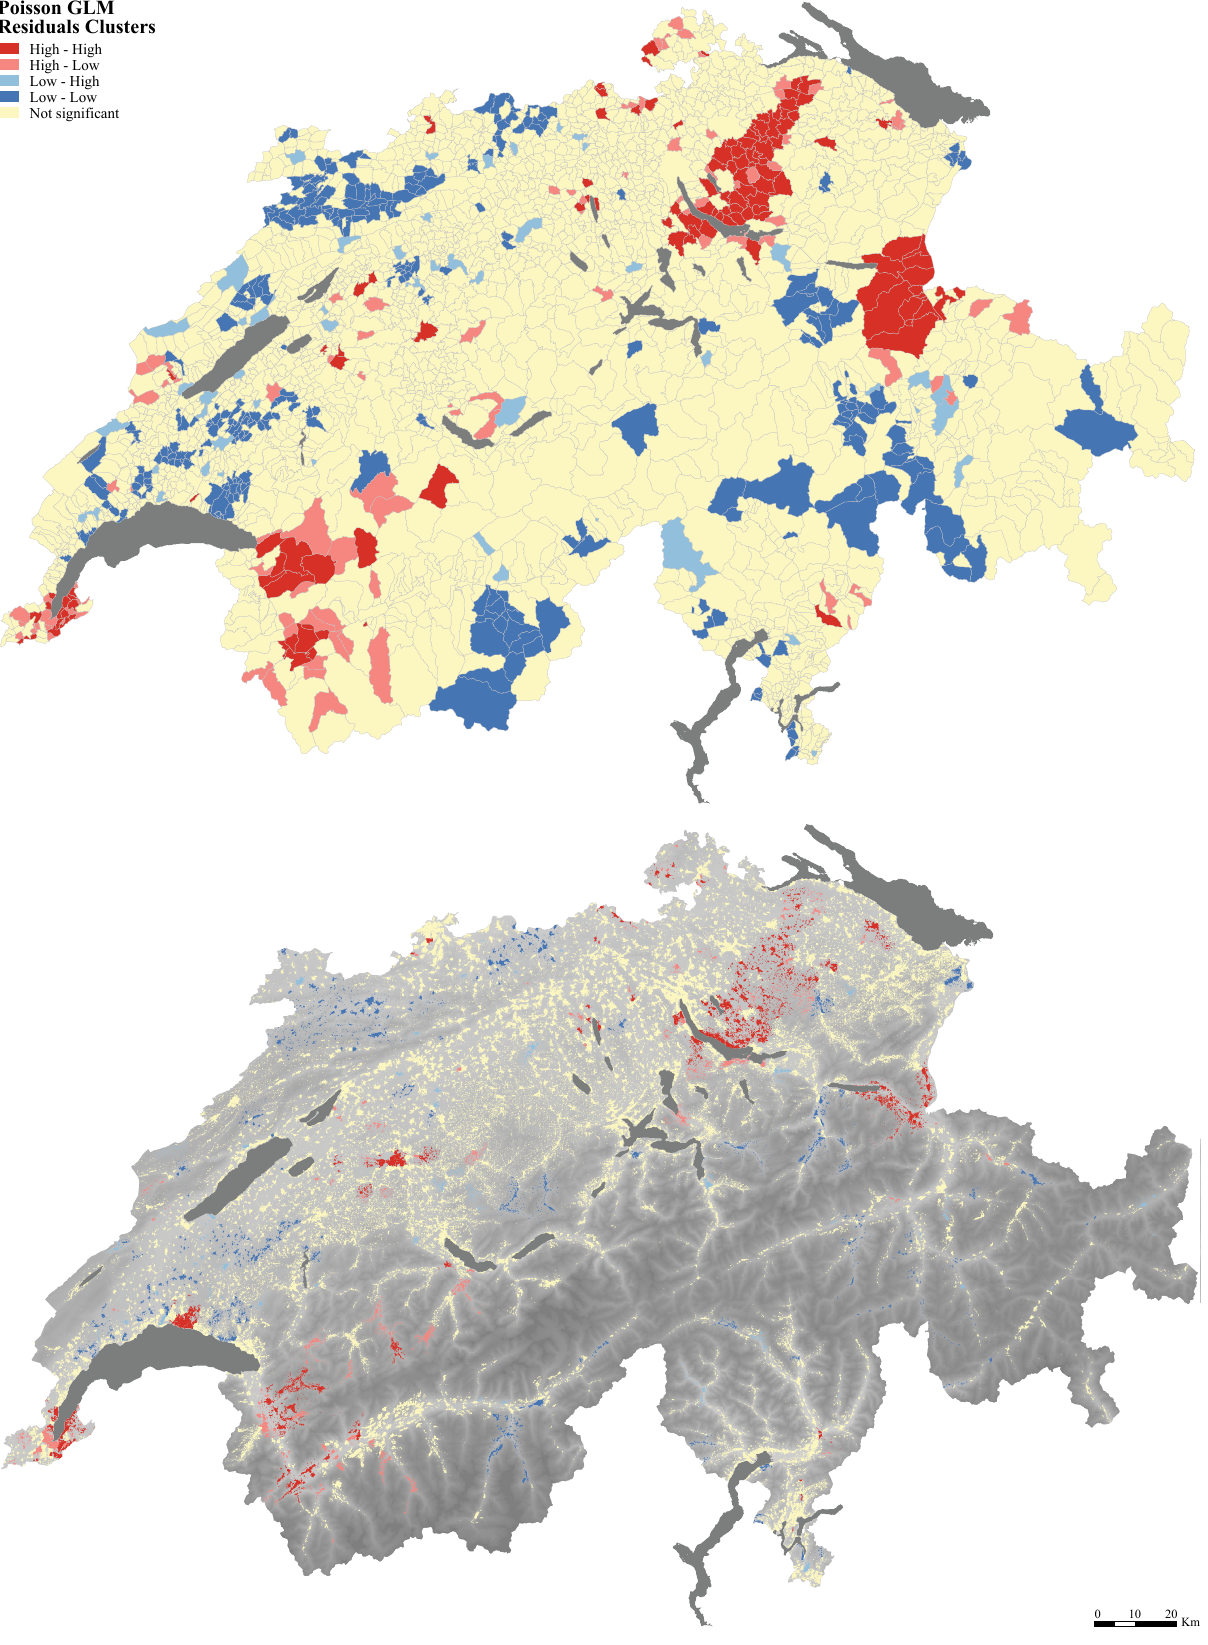
Figure 3. Dog tumor incidence count model residuals clusters for unrefined municipality units (top) and dasymetrically refined units (bottom) (data: SFOT,